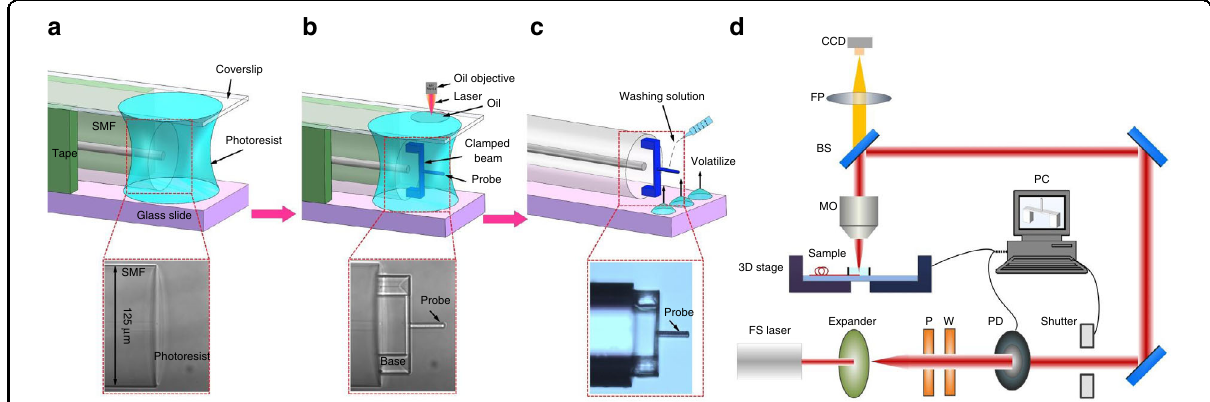
Fig. 9 Fabrication process of the device. a A drop of photoresist solution is dropped into the end face of the SMF, and the coverslip is pressed on the side of the fi ber to prevent the photoresist from fl owing during polymerization. b Femtosecond laser polymerizes a clamped-beam probe structure on the end face of the fi ber c Remove the coverslip on the top of the optical fi ber and wash the uncured photoresist with the cleaning solution composed of acetone and isopropanol. d Schematic diagram of the optical path of the TPP micro – nano